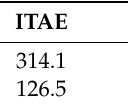
Table 2. Results of SMC and NNNFTSMC for step response.